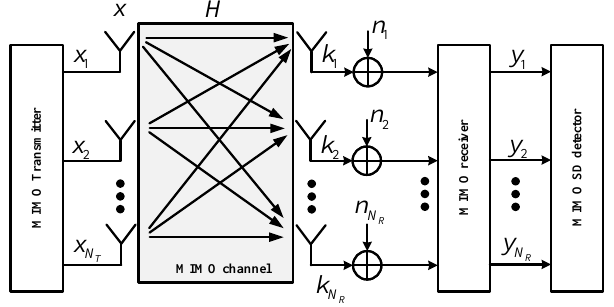
Figure 1. Block diagram of the general MIMO system with SD. with less resource utilization compared to the prior